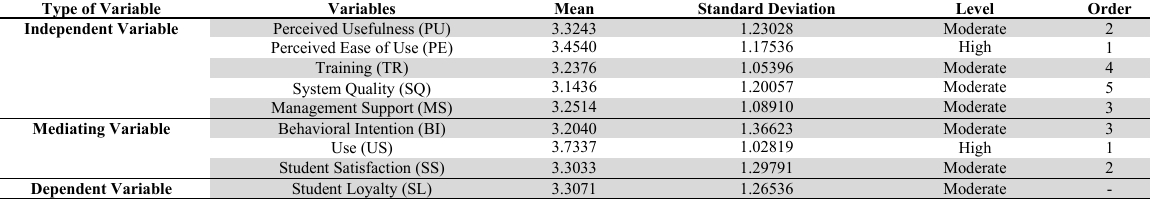
Table 2 Overall mean and standard deviation of the study’s variables Type of Variable